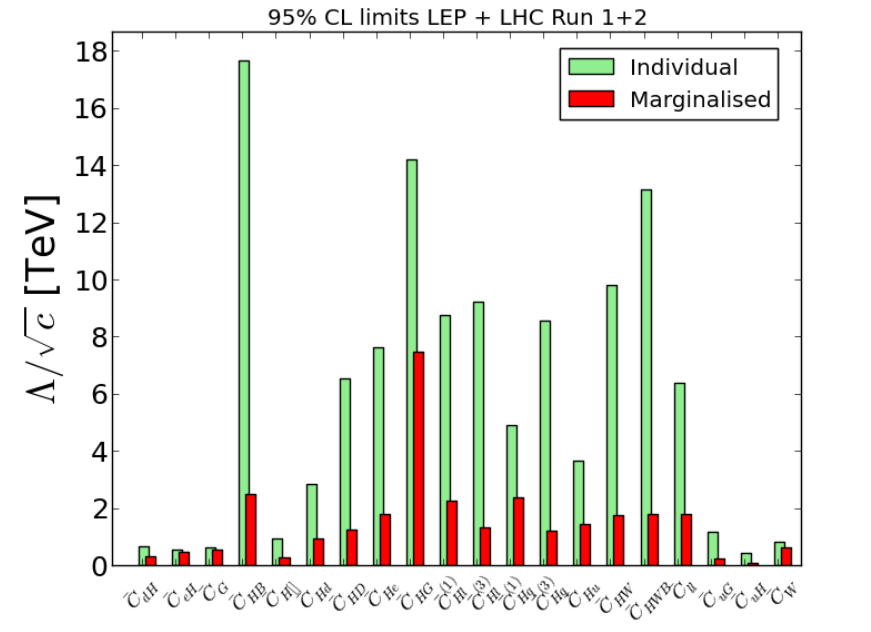
Figure 8. Summary of the 95% CL bounds on the sensitivity (in TeV) for an O (1) Wilson coe(cid:14)cient, obtained from marginalised (red) and individual (green) (cid:12)ts to the 20 dimension-6 operators entering in electroweak precision tests, diboson and Higgs measurements at LEP, SLC, and LHC Run 1 and